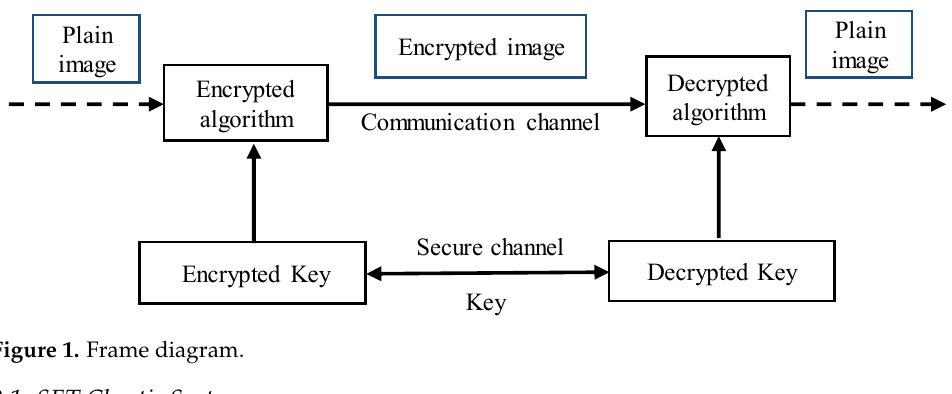
Figure 1. Frame Figure 1. Frame diagram.